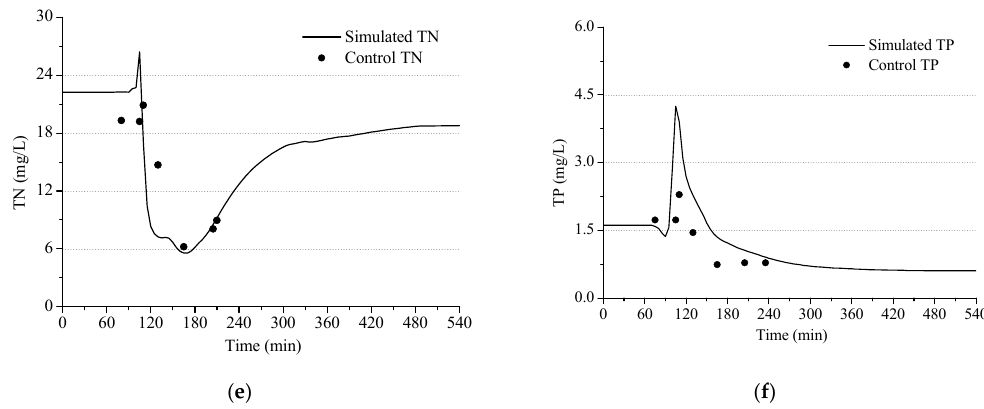
Figure 3. Simulation curves and measured values of each pollution index, ( a ) flow, ( b ) chemical oxygen demand (COD), ( c ) suspended solid (SS), ( d ) ammonia nitrogen (NH 4 ‐ N), ( e ) total nitrogen (TN), ( f ) total phosphorus (TP).